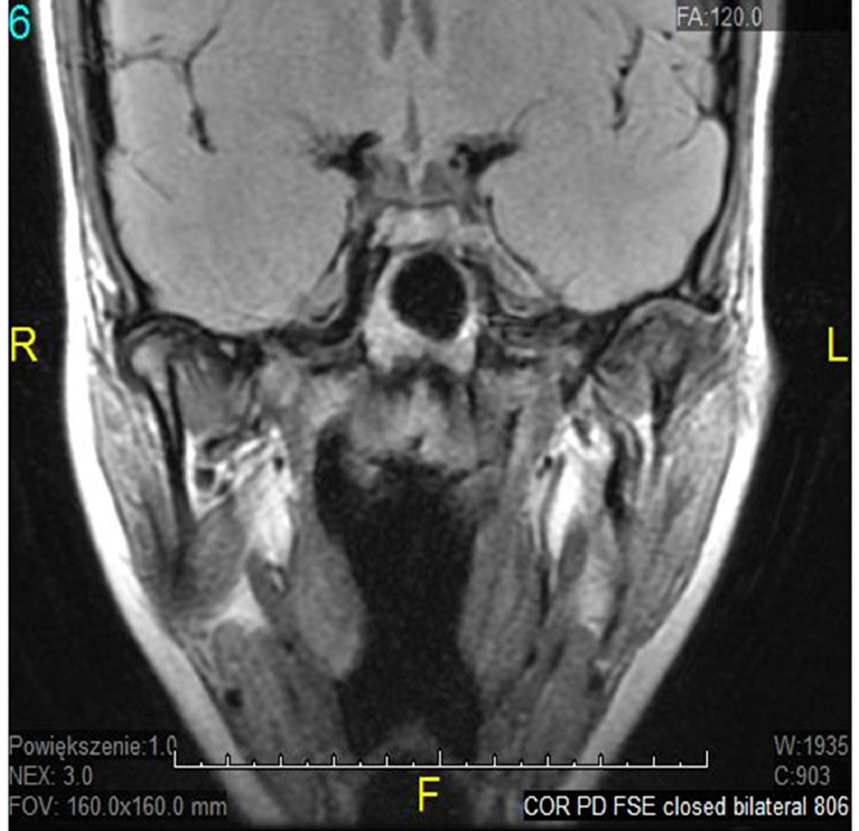
Figure 3. ADDwoR coronal view—closed.